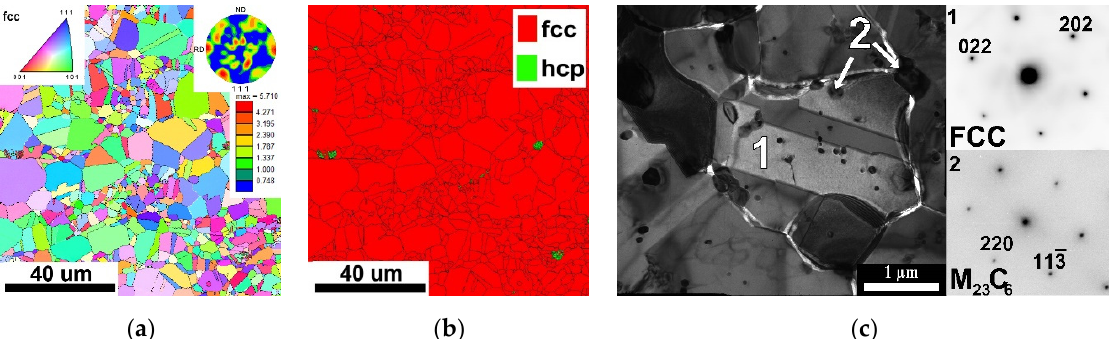
Figure 2. Inverse pole figure (IPF) electron back-scattered diffraction (EBSD) map ( a ), phase map ( b ), and bright field TEM image ( c ) of the initial microstructure of the Fe 49 Mn 30 Cr 10 Co 10 C 1 alloy; selected area diffraction patterns taken from the fcc phase (1) and M 23 C 6 carbides (2) are shown in ( c ). {111} pole figure is inserted in ( a ); the color scale is valid for all pole figures hereafter.